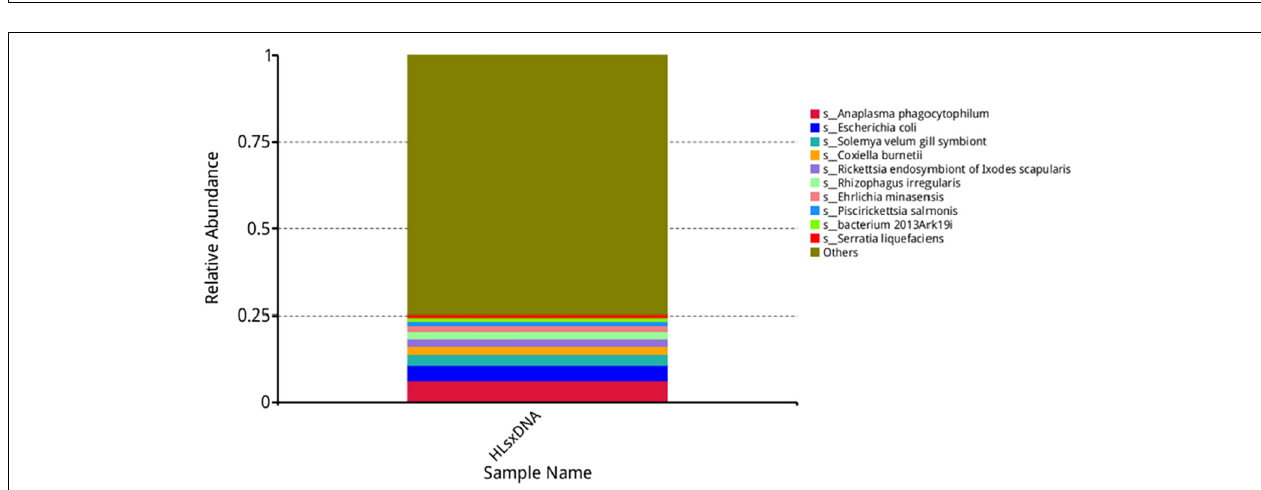
FIGURE 6 | Relative abundance of the top 10 genera. The horizontal axis presents the sample names, the vertical axis presents the relative proportion of species annotated to a certain type, and the genera corresponding to individual color blocks are indicated in the legend on the right.